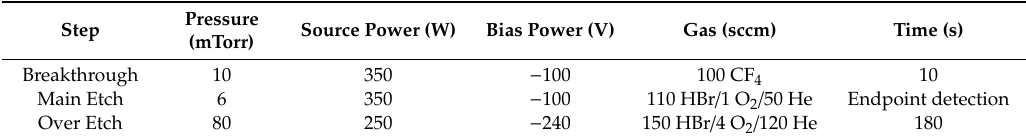
Table 2. Etch conditions of